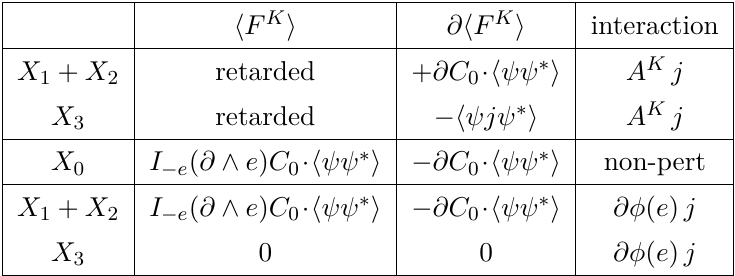
Table 1 . Contributions and cancellations for the Gauss